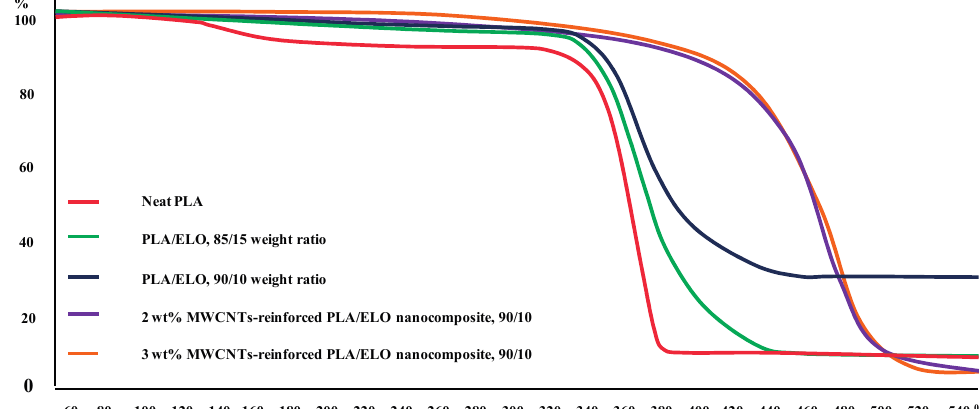
Figure 4. Thermo gravimetric analysis (TGA) curves for neat PLA, PLA/ELO (85:15), PLA/ELO (90:10), MWCNTs-reinforced PLA/ELO